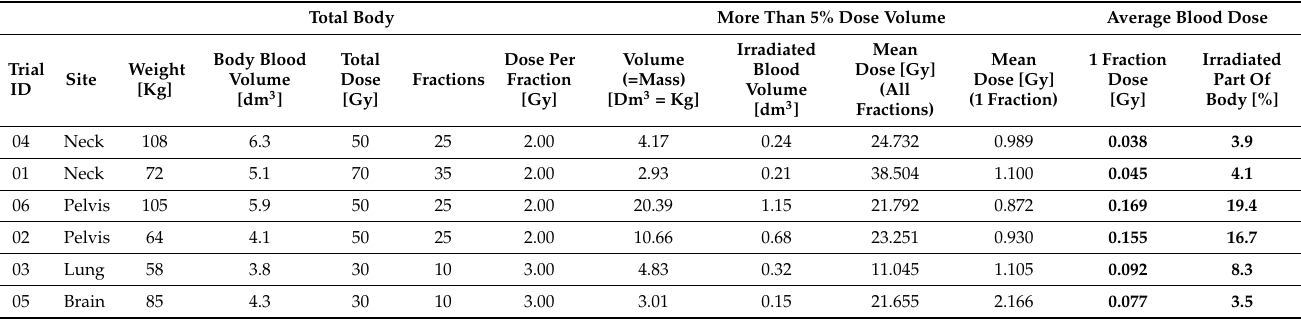
Table 2. Blood dose